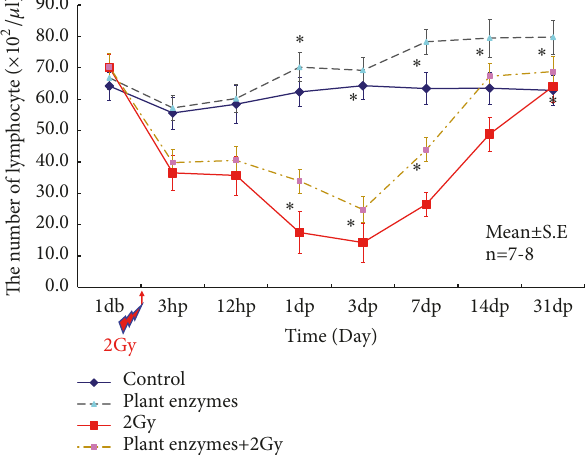
Figure 6: Single-dose effect of Validux Plant Enzyme on blood lymphocyte counts in mice. There were 7-8 animals in each experimental group. Data are mean ± standard deviation values. Statistically significantly different ( ∗ P < 0.05 ) from the control group. Statistically significantly different ( ∗ P < 0.05 ) from the 2Gy